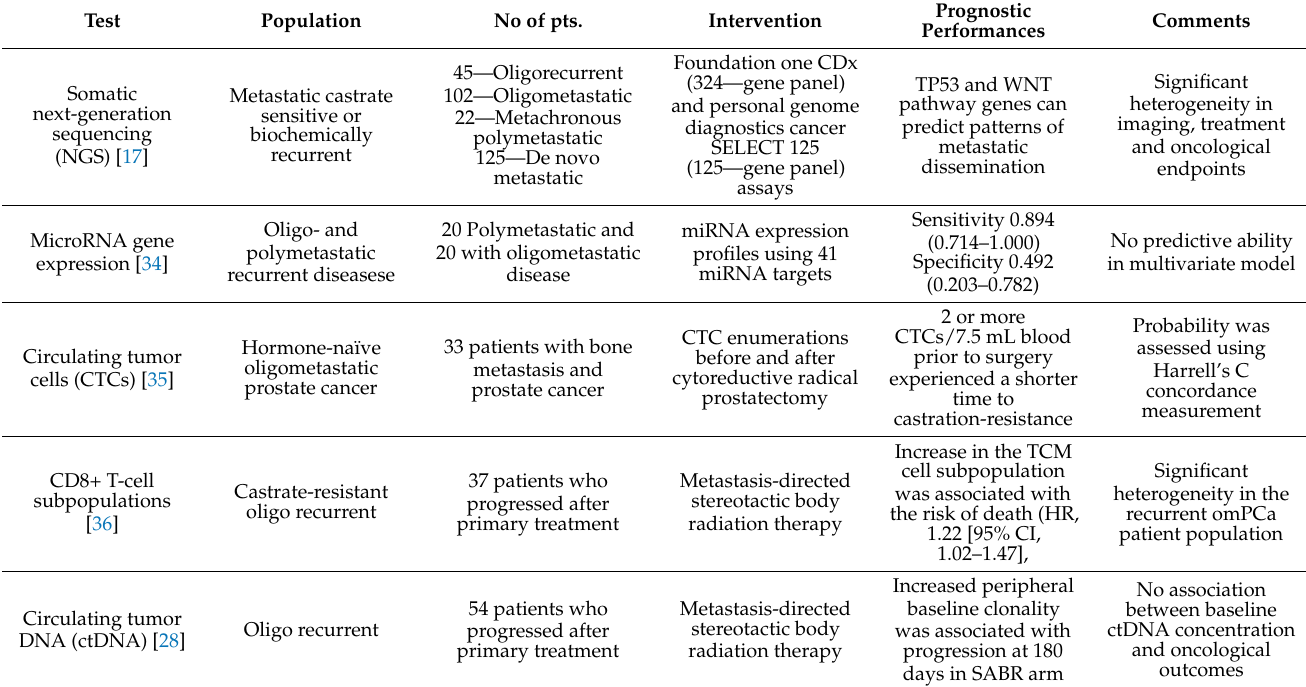
Table 2. Results of current biomarker tests in oligometastatic prostate cancer